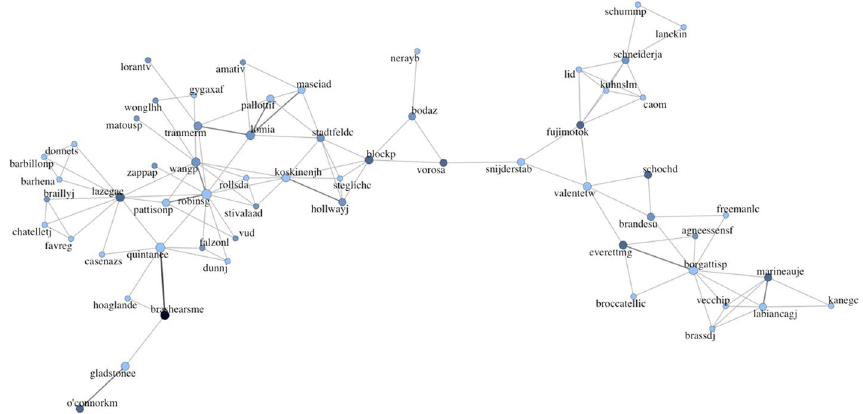
Fig. 4 Social Network Analysis Journal’s main component. Source: Elaborated by the authors using the database of this